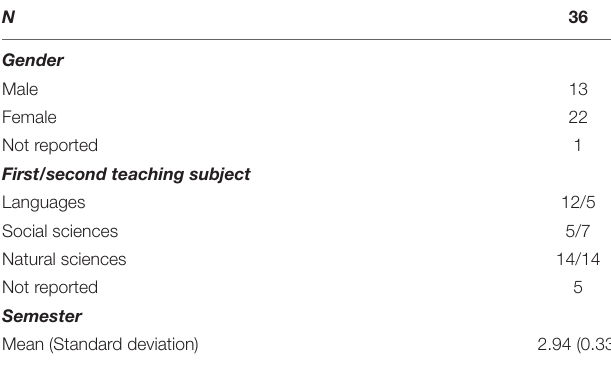
TABLE 1 | Characteristics of participants in the longitudinal